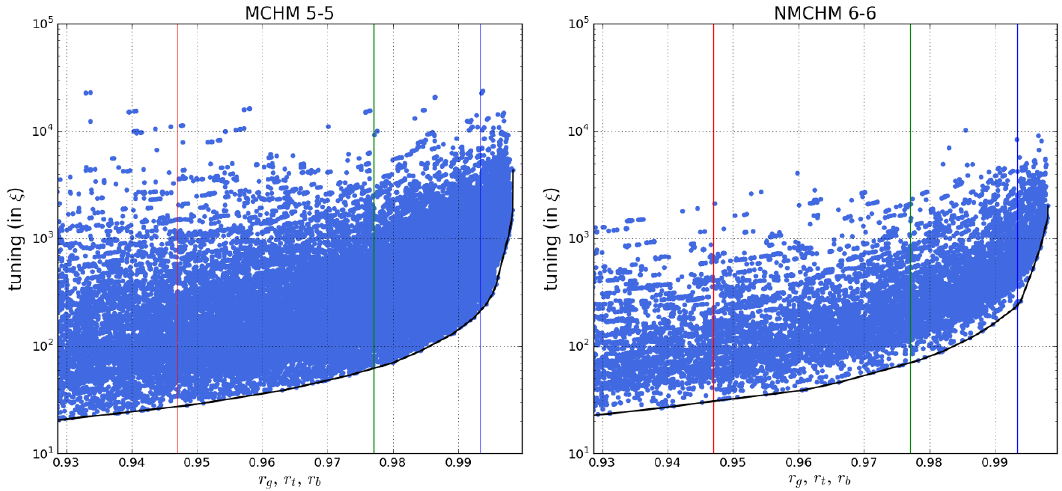
Figure 6. Comparison of the (cid:12)rst-order tuning contribution from the vacuum misalignment (cid:24) , in the Higgs-gluon, -top and -bottom coupling deviation. The red line shows the expected precision of a 250 GeV ILC, green a 500 GeV ILC, and blue a high-luminosity 1 TeV ILC.